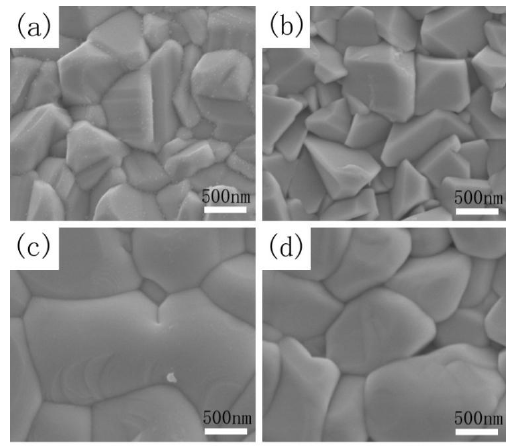
Figure 4. SEM images of CZTSSe annealed at ( a ) 530 °C and CMZTSSe films annealed at ( b ) 500; ( c ) 530; and ( d ) 560 °C.